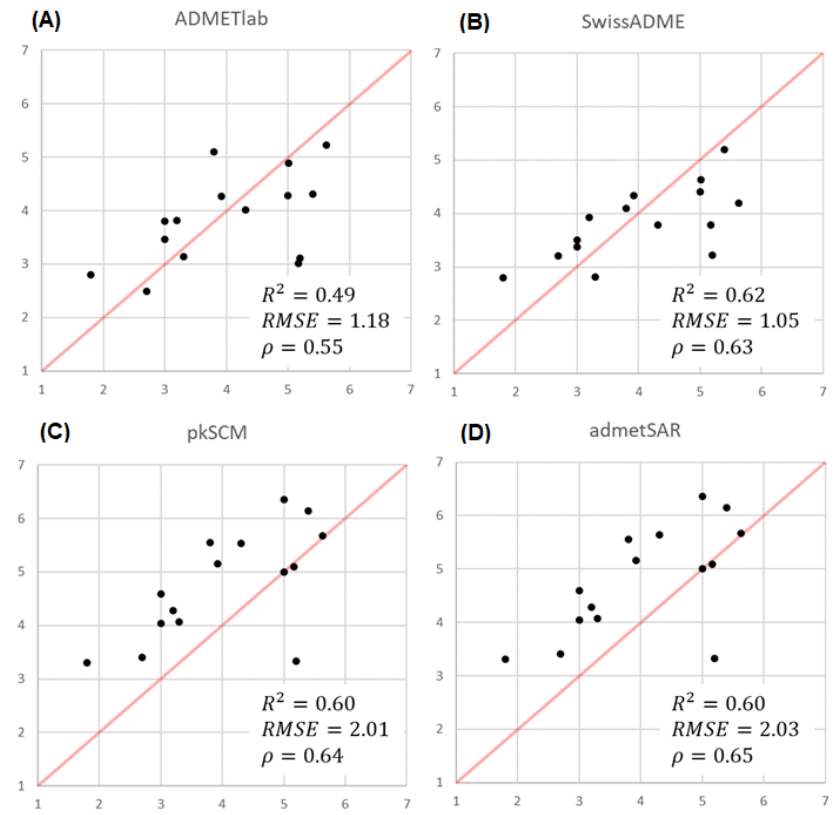
Figure 5. Scatter plot of experimental vs. predicted log P values when using ( A ) ADMETlab, ( B ) SwissADME, ( C ) pkSCM, and ( D ) admetSAR. The correlation coefficient R2, the Root Mean Squared Error, and the Spearman Rank correlation coefficient (\rho) are reported for every regression model.